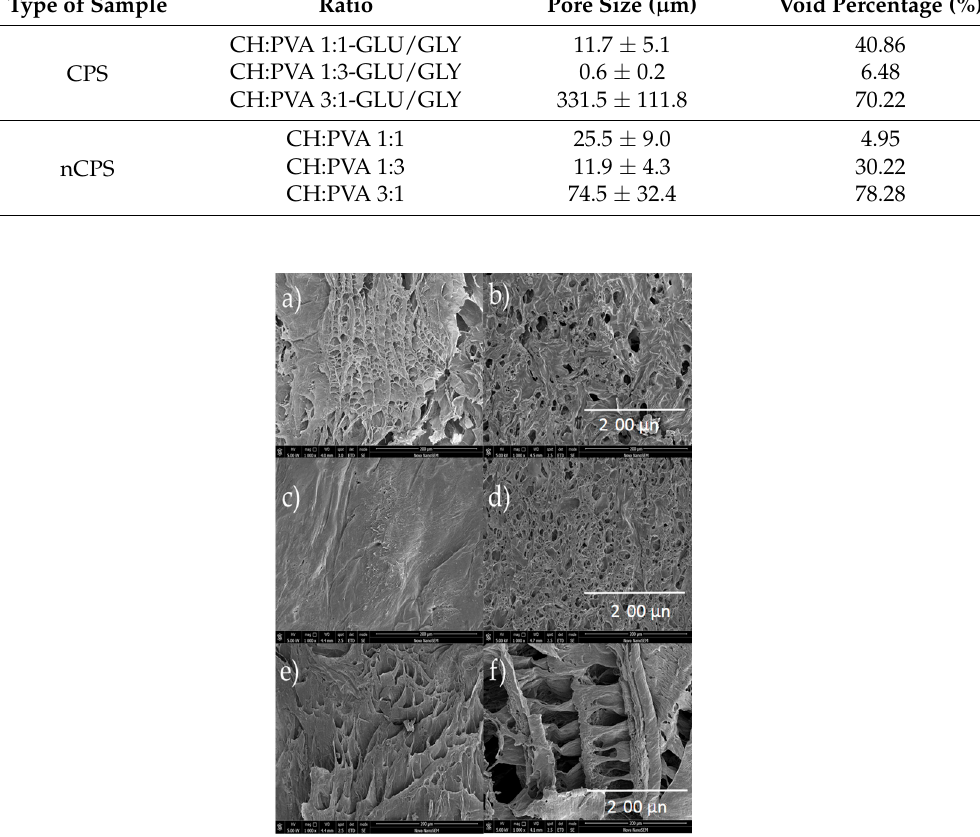
Figure 5. Surface SEM images for CPS ( left ) and nCPS ( right ) at 250×. ( a ) CH:PVA 1:1 GLU-GLY; ( b ) Table 4. Obtained pore size for the evaluated scaffolds.